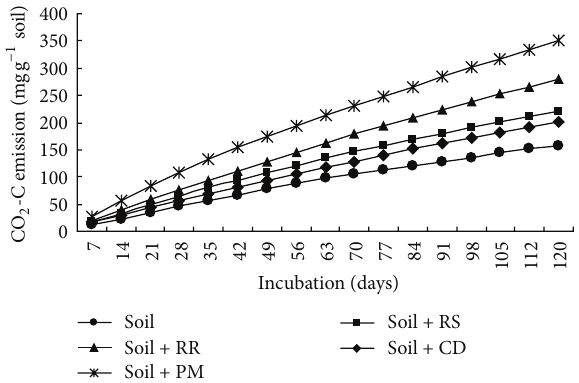
Figure 3: Rate of decomposition from different organic residues.